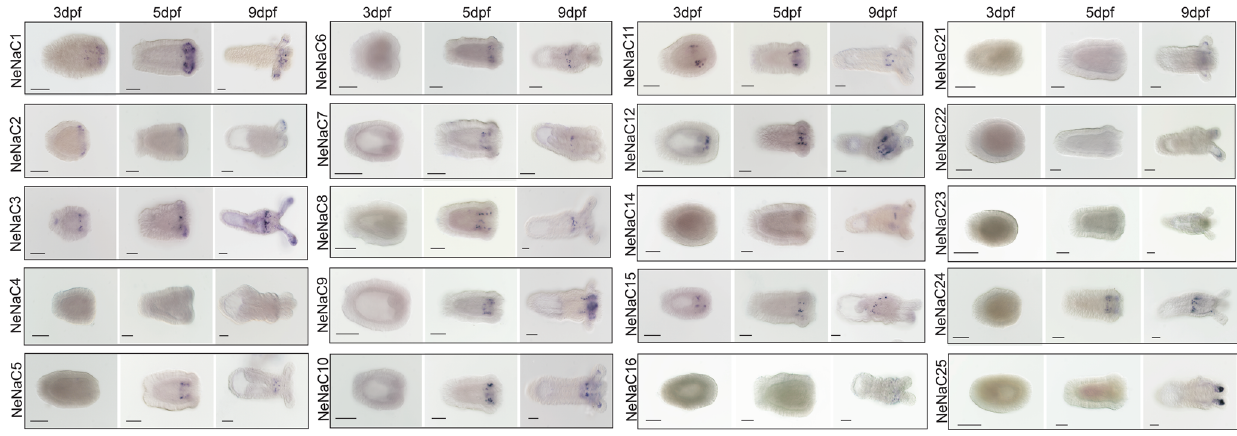
Fig. 2 In situ Hybridization of selected NeNaCs at three different developmental stages in N. vectensis . The expression is noticeable by the blue stain (NBT/BCIP crystals). Oral end of the animals is to the right for each panel. dpf days post-fertilization. Scale bars: 100 µ